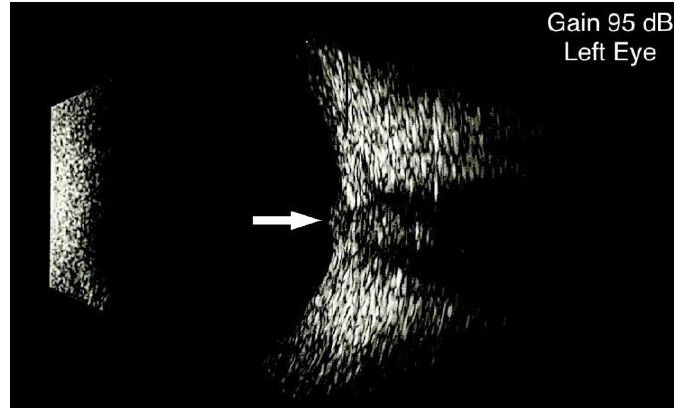
Figure 1. Optic nerve B-scan ultrasound in a child in which the optic nerve head is visible (white arrow). the presence of the optic nerve head in the ultrasound scan at the point where it emerges at the level of the retina, with no interposed scleral tissue, is a prerequisite for making ONSD measurements with B-scan ultrasonography.